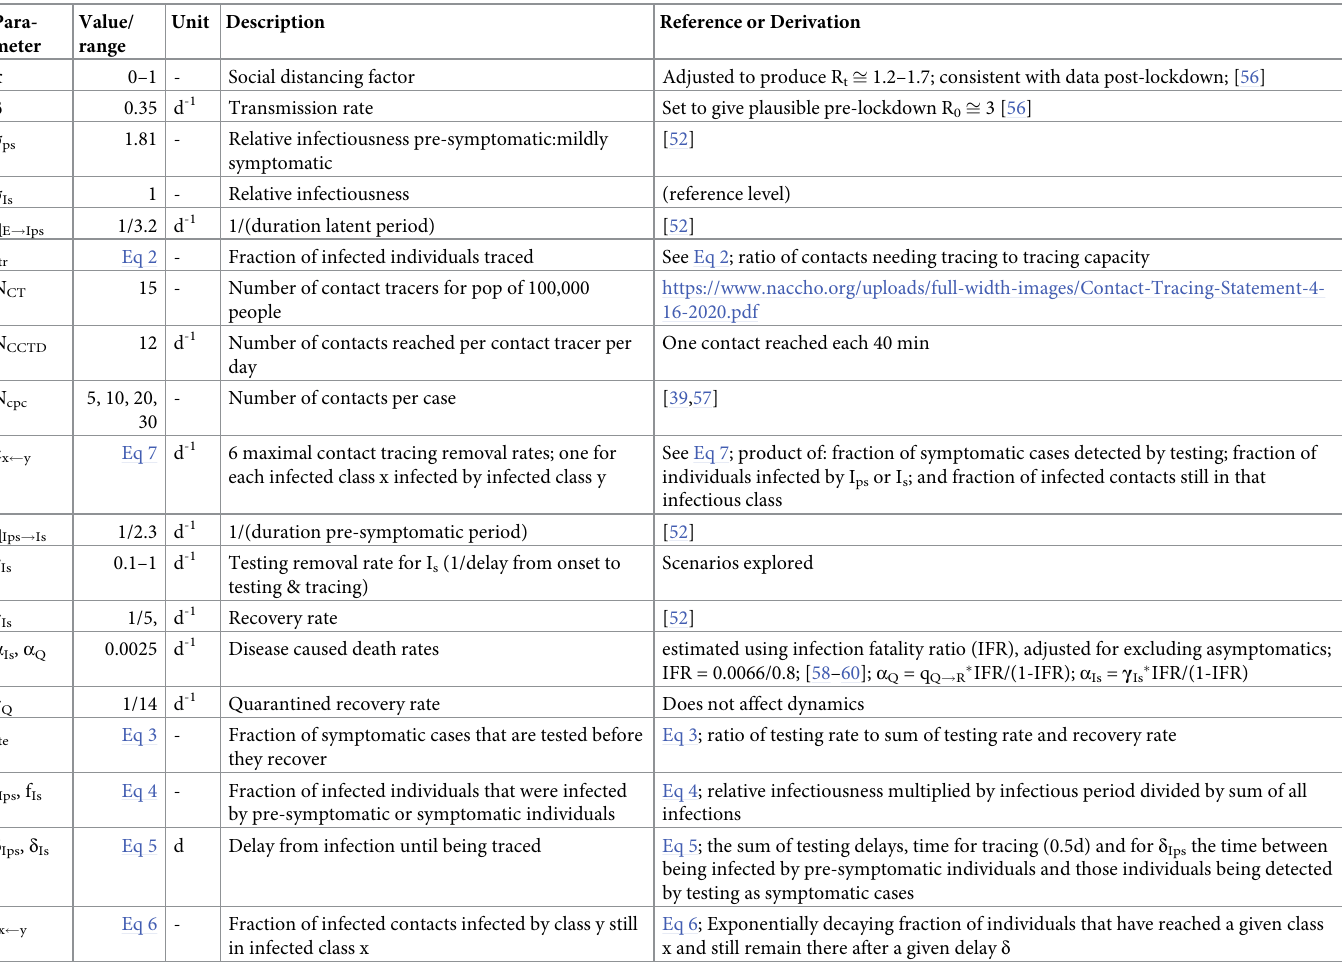
Table 1. Parameter values and descriptions. Time units for each parameter are either time in days (d), the inverse of time (d -1 ) or unitless (-). Para-